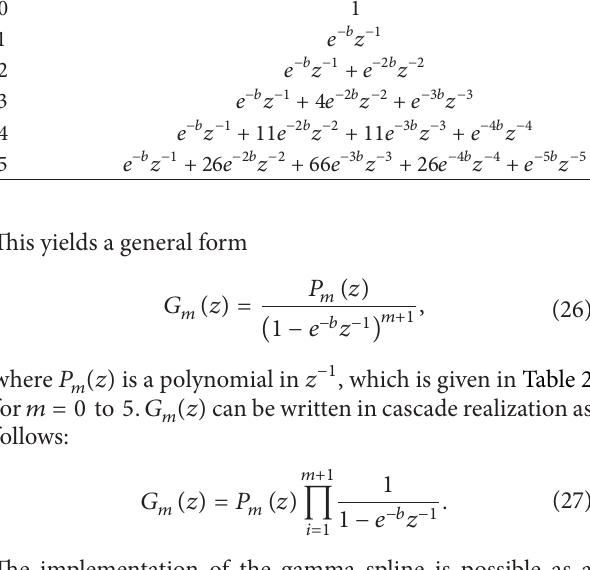
Table 2: 𝑃 𝑚 (𝑧) polynomial for 𝑚 = 0 to 5 .